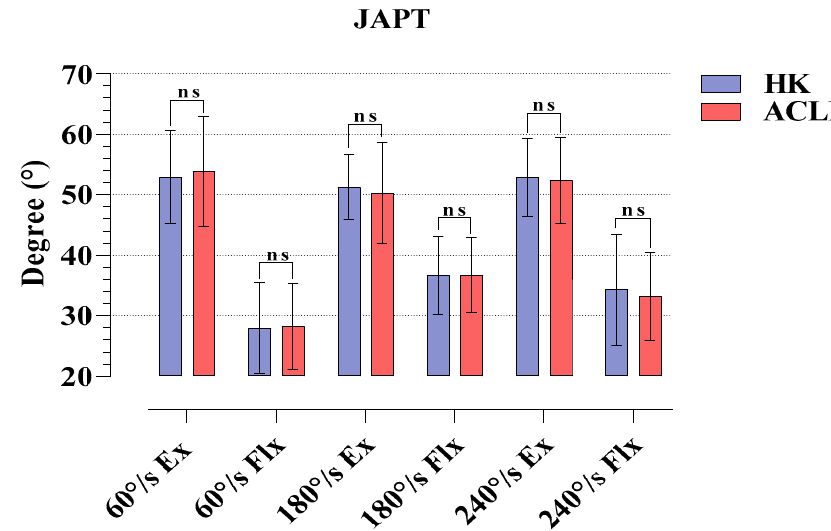
Figure 3. Comparison of JAPT values obtained in isokinetic tests for HK and ACLR. ns, nonsignificant; HK, healthy knee; ACLR, anterior cruciate ligament reconstruction knee.